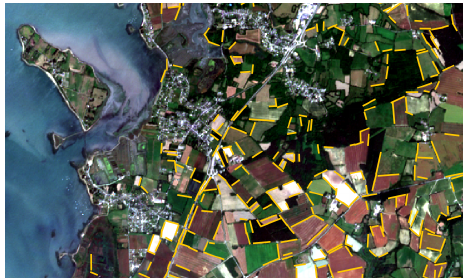
Figure 3. Detected segments on an extract of Sentinel2 image (10m resolution)